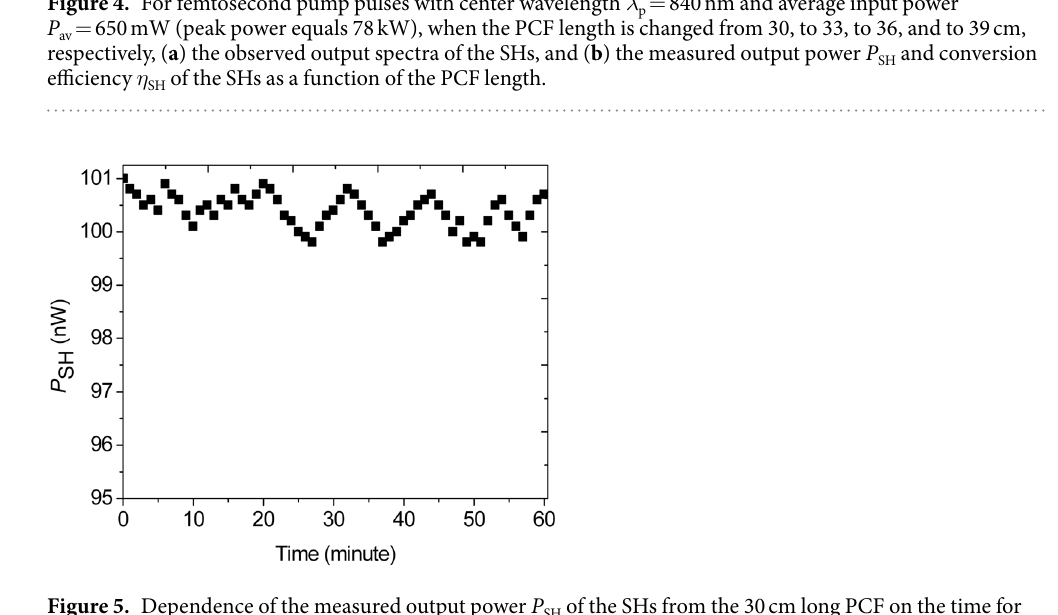
Figure 5. Dependence of the measured output power P SH of the SHs from the 30 cm long PCF on the time for femtosecond pump pulses with center wavelength λ p = 840 nm and average input power P av = 650 mW (the peak power of 78